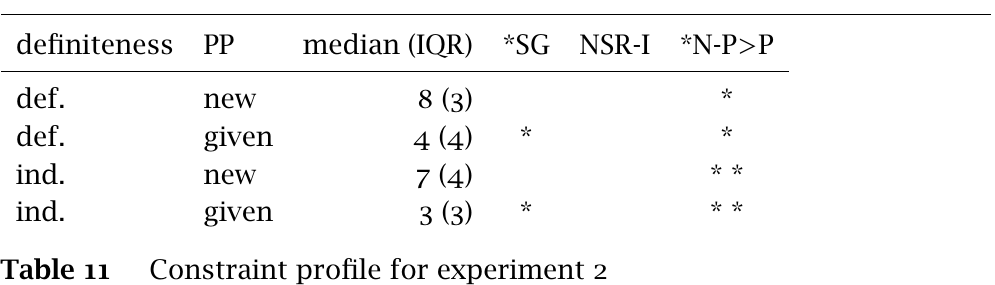
Constraint profile for experiment